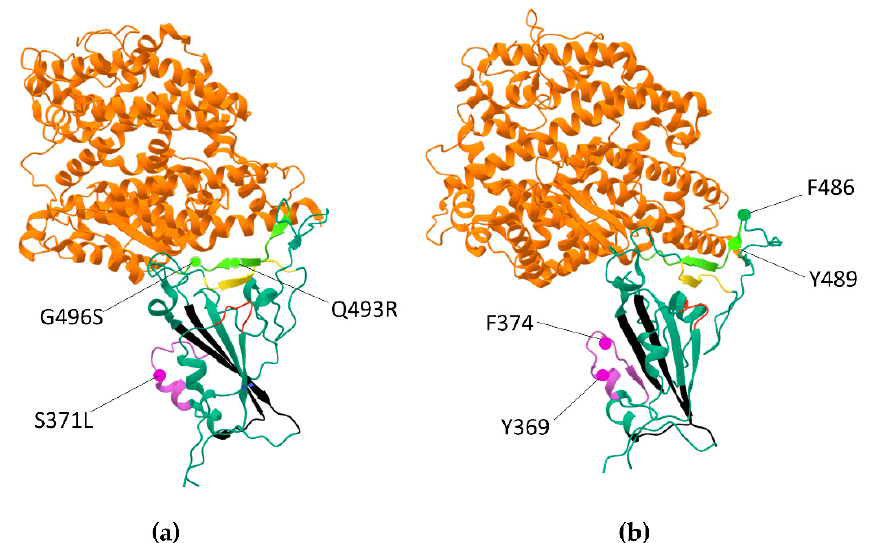
Figure 3. The 3D structure of Omicron BA.1 RBD bound to ACE2 according to 7T9L (https://www.rcsb.org/3d-view/7T9L/1, accessed on 20 June 2022). Omicron amyloidogenic tracts are as in Figure 2c. ( a ) Positions of Q493R, G496S, and S371L (R490, S493, and L368 in Omicron BA.1) are indicated as round shapes. Q493R and S371L are located in the longer amyloidogenic tracts and are critical for immune evasion. ( b ) Positions of Y369/F374 (Y366/F371 in Omicron) and F486/Y489 (F483/Y486 in Omicron) are indicated as round shapes. The 3D Omicron BA.1 RBD—ACE2 structure is rotated relative to ( a ).